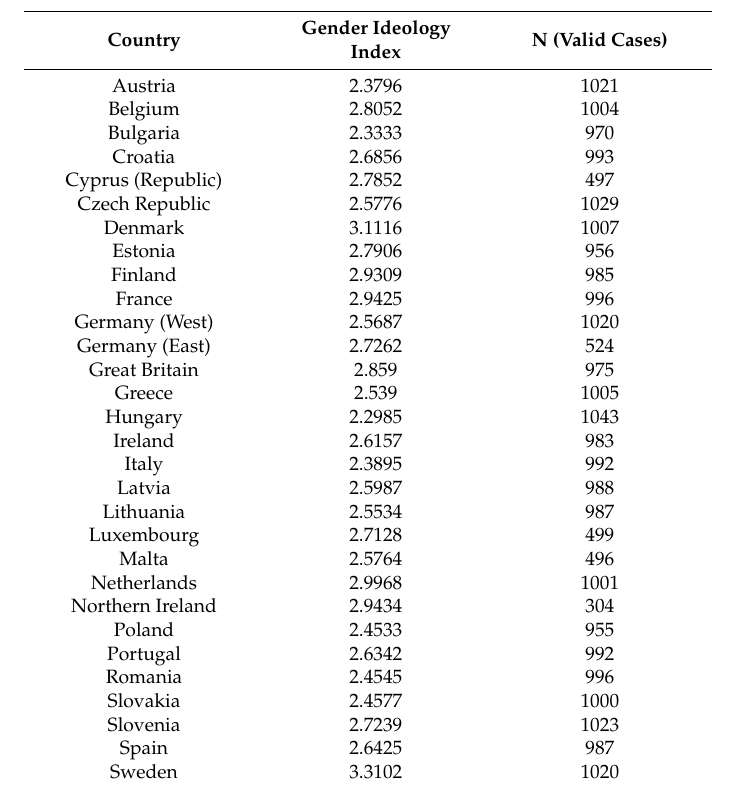
Table 3. Support for egalitarian gender roles (Gender Ideology